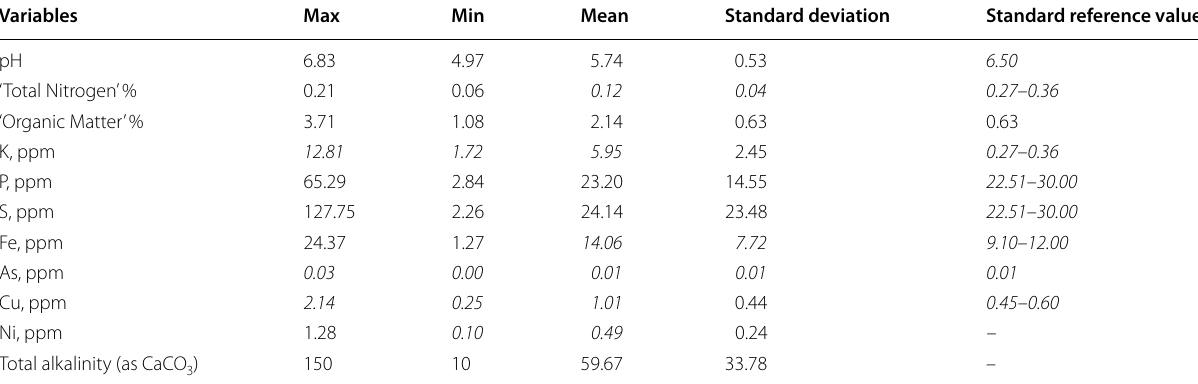
Table 1 The value of different chemical parameters and their max, min, mean, and standard deviation as well as standard reference value for respective parameter